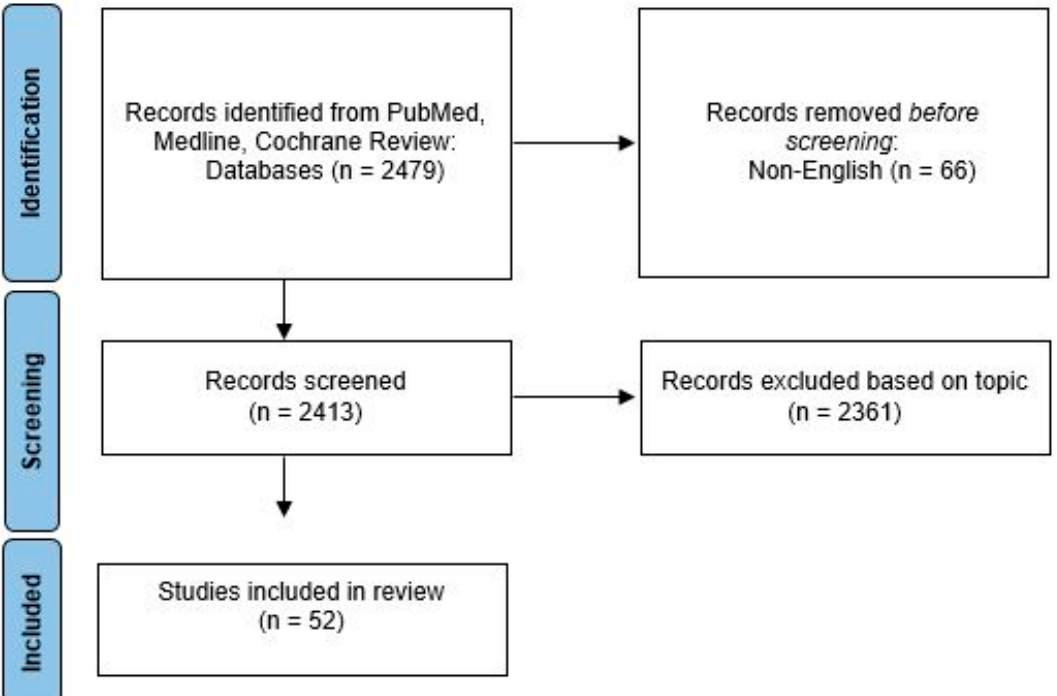
Figure 1. Flow diagram of the included studies. Table 1. Studies included in the literature review.